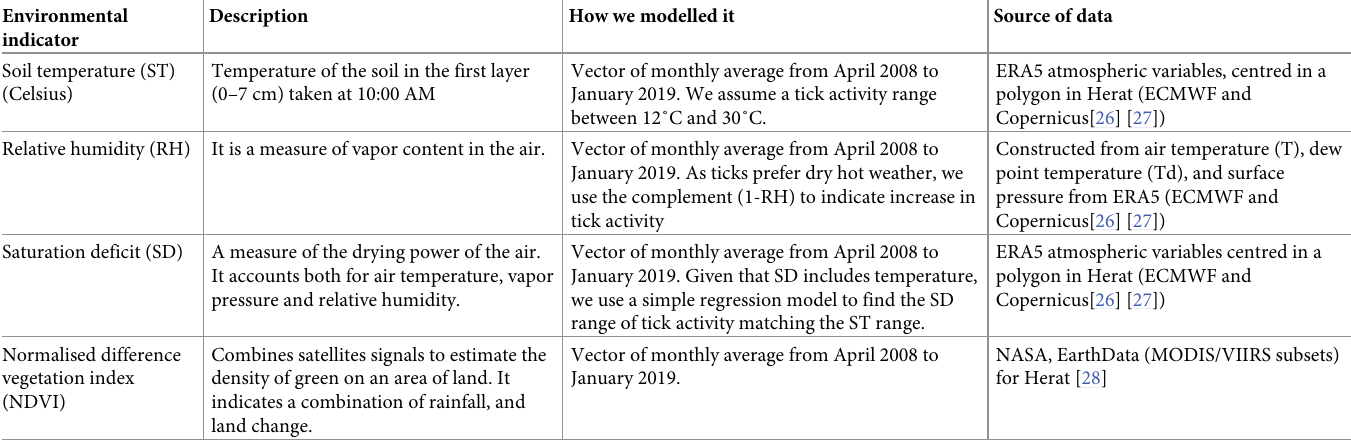
Table 2. Environmental drivers as surrogate markers of tick activity. Environmental indicator